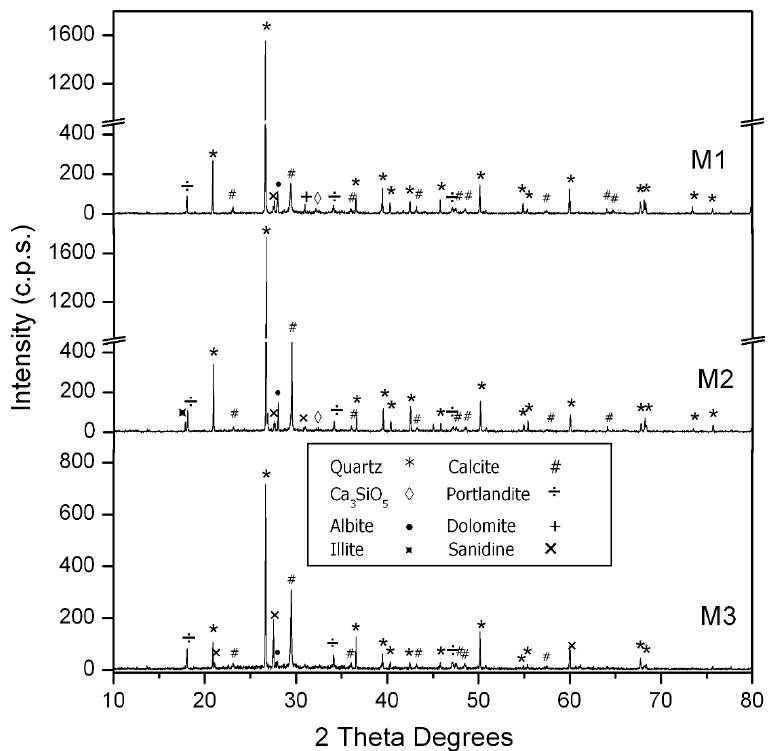
Figure 6. Powder X-ray diffraction (PRXD) diagrams of Family-1’s mortars.